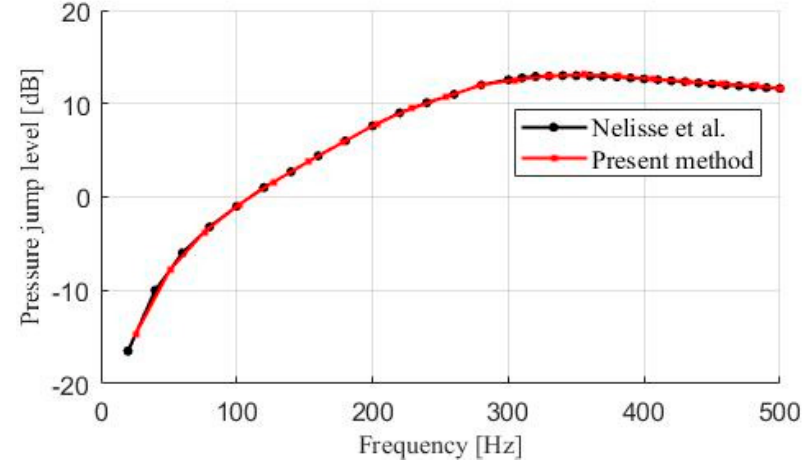
Figure 5. Pressure jump across a rigid plate at a